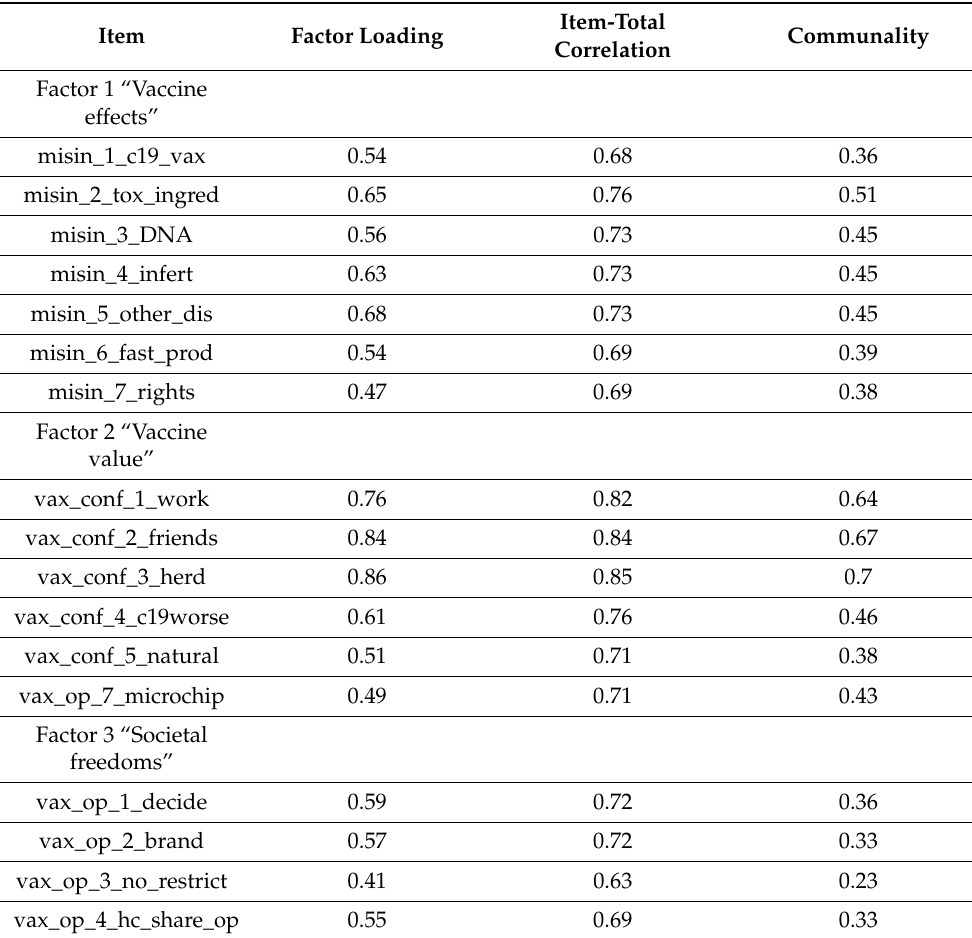
Table 1. Factor Loadings, item-test correlation, and